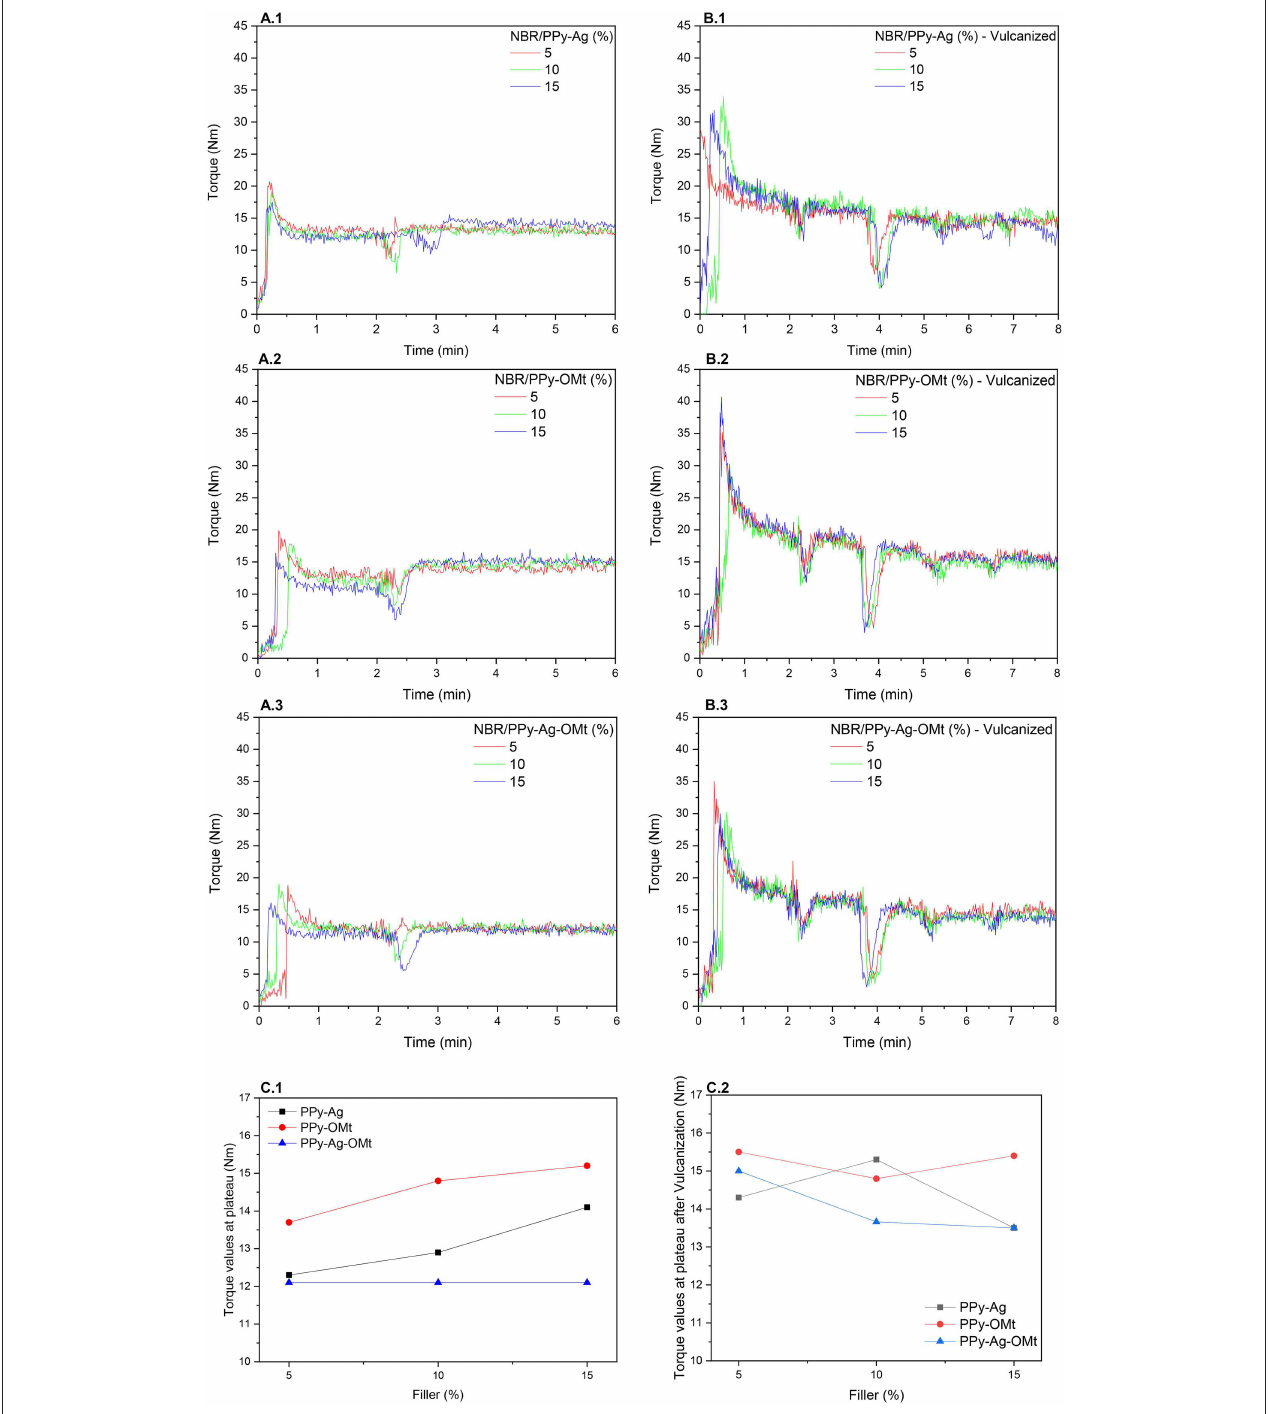
FIGURE 1 | Torque curves of NBR/PPy composites. (A.1–A.3) Components mixing curves; (B.1–B.3) NBR/PPy composites combined with the vulcanizing system; and (C.1,C.2) torque values at the plateau vs. PPy composite